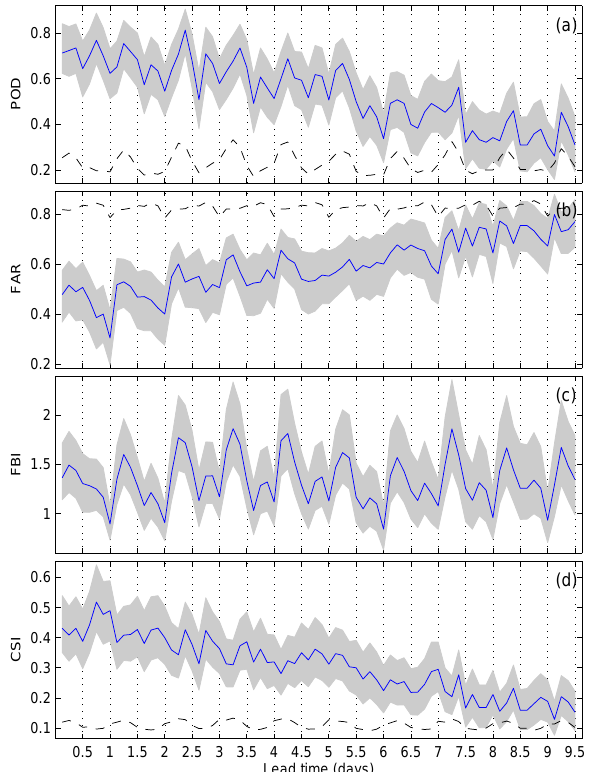
Fig. 7. As in Fig. 6, but for categorical evaluation scores: (a) POD, (b) FAR, (c) FBI, and (d) CSI. The mean scores (except FBI) of the reference forecasts are also shown in dashed lines.